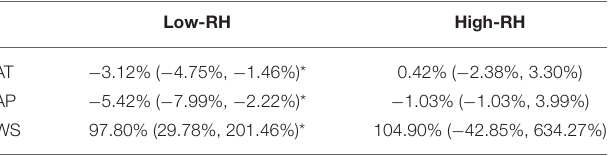
TABLE 3 | Estimates of percent change (95% CI) in weekly influenza cases associated with a 1-unit increase in other meteorological parameters stratified by RH.